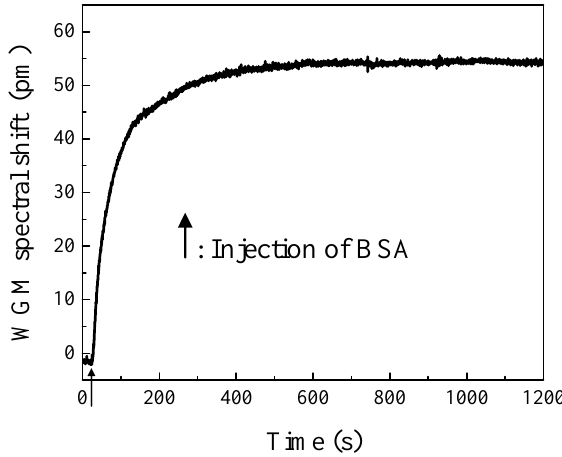
Figure 4. Sensorgram of BSA binding to the PDC cross-linker on the silanized microsphere surface. The total WGM shift is 54 pm, corresponding to a BSA surface density of 3.4x10 12 /cm 2 . Arrow indicates when BSA solution is added. BSA concentration is 0.8 mg/mL. Sphere size: R = 100 µ